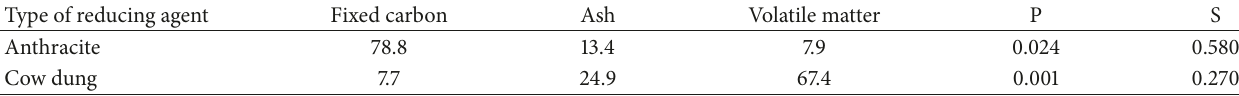
Table 2: Proximate analysis of reducing agent (wt%).